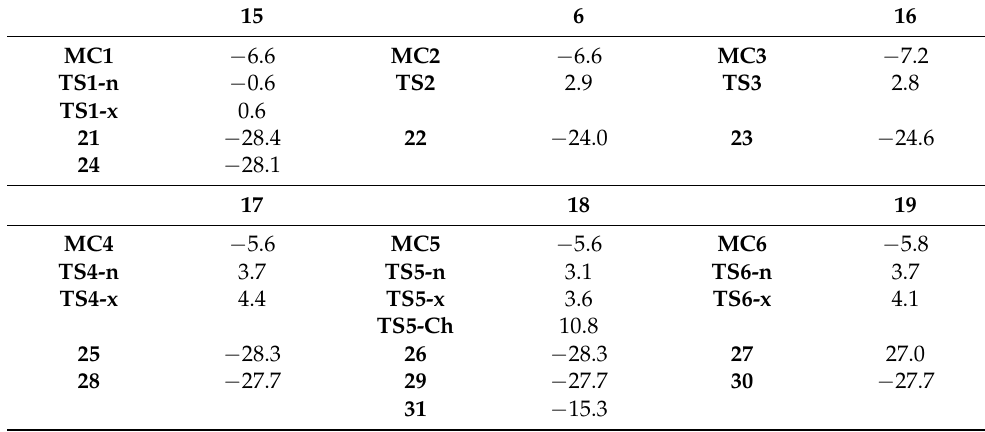
Table 2. ω B97XD/6-311G(d,p) relative electronic energies in acetonitrile, kcal · mol − 1 , of the stationary points involved in the I-DA reactions of iminium cations 6 , 15 – 19 with Cp 1